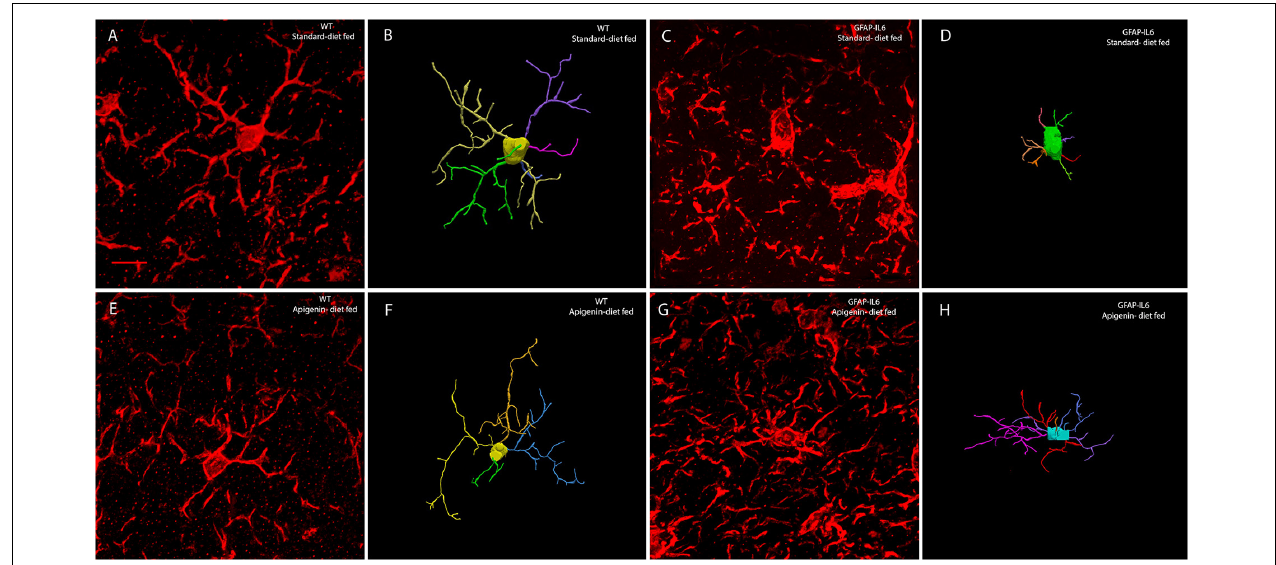
FIGURE 5 | Representative confocal images of reconstructed microglia from WT standard diet-fed (A,B) , GFAP-IL6 standard diet-fed (C,D) , WT apigenin-fed (E,F) , and GFAP-IL6 apigenin-fed (G,H) cohorts. The extended depth of focus images obtained from collapsing 3D confocal microscopy images of Iba-1 + microglia obtained under 63 × oil immersion objective, along with the corresponding manually reconstructed images in Neurolucida 360. GFAP-IL6 mice (apigenin diet) (G,H) had a significantly reduced soma area, soma perimeter and a larger number of nodes than that of GFAP-IL6 mice (standard diet) (C,D) . (Scale bar 10 µ m).